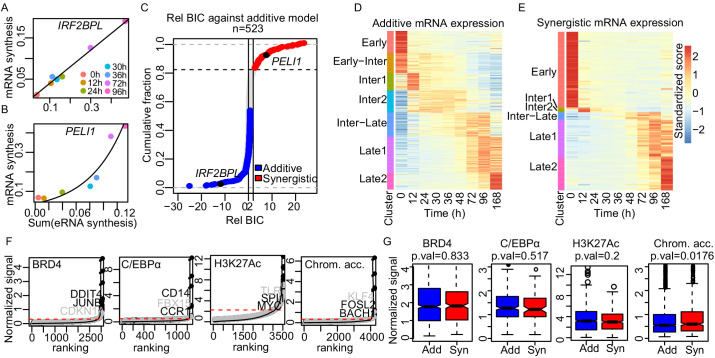
Enhancer cooperation can be additive or synergistic.(A and B) Exemplary curve fits of the additive (A) and the synergistic models (B) to the observed size factor and length normalized TT-seq RNA synthesis level for the indicated mRNA and the sum of the paired eRNAs. (C) The relative Bayesian Information Criterion (BIC) for the curve fits for a total of 523 promoters reveals that RNA synthesis at most loci follows either the additive or the synergistic model. The synergistic model fitted better for 17% of tested loci, showing a relative BIC greater than 2 (red). Any loci with a relative BIC between 0 and 2 were left as ambiguous because they fitted both models (gray). (D and E) Heatmap of gene expression (RNA-seq) regulated in additive (n = 348) (D) or synergistic (n = 136) (E) manner. Clusters are as shown in Figure 1C (k-means). (F) ChIP signal for BRD4, C/EBPα, and H3K27Ac, and ATAC-seq signal, ranked by signal strength on the peaks within 1 kb of our enhancers (Materials and methods, black dots) with cut-off values for superenhancers (red dashed lines). Synergistic enhancers are depicted with gray dots. (G) Additive (blue) and synergistic (red) enhancers are compared for their occupancy with BRD4, C/EBPα, H3K27Ac, or their chromatin accessibility (ATAC-seq). The comparison was carried out for the time point where the highest signal was observed. Fold differences in median signal of BRD4, C/EBPα, H3K27Ac, and chromatin accessibility between additive and synergistic enhancers are 1.02, 0.96, 1.07, and 1.09, respectively.